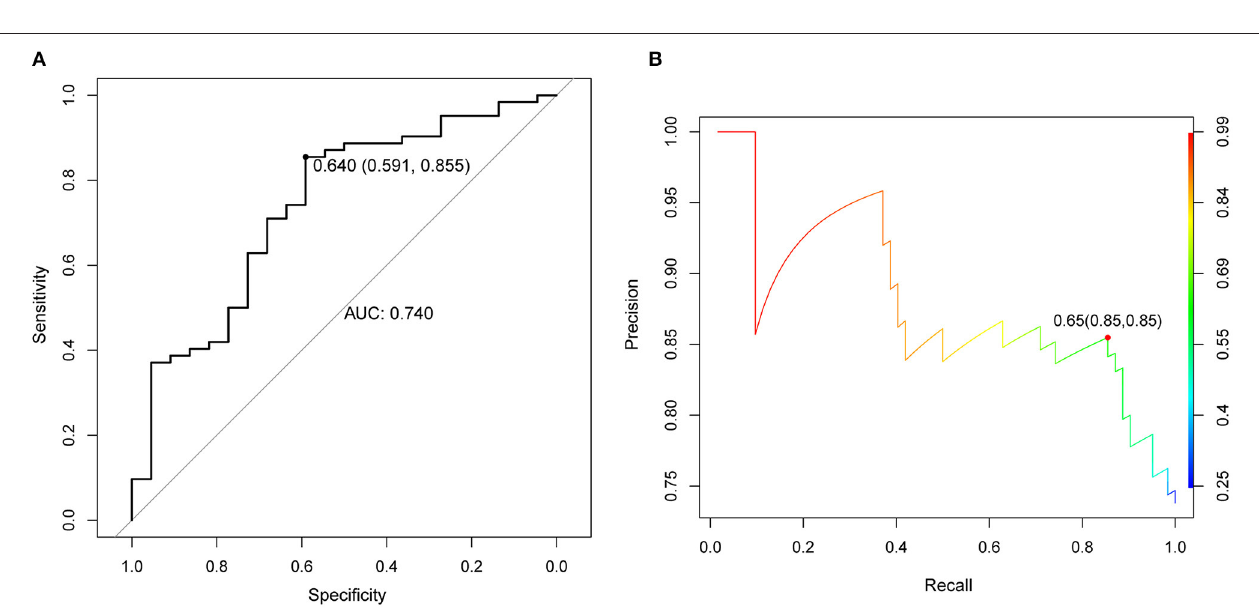
FIGURE 3 | A random forest analysis was trained to estimate the important values of immune infiltration class. (A) Random forest classifier analysis. The y-axis represented the mean decreased accuracy and mean decreased gin score, while the x-axis represented immune cell types. (B) The mean decreased accuracy of immune infiltration subsets.